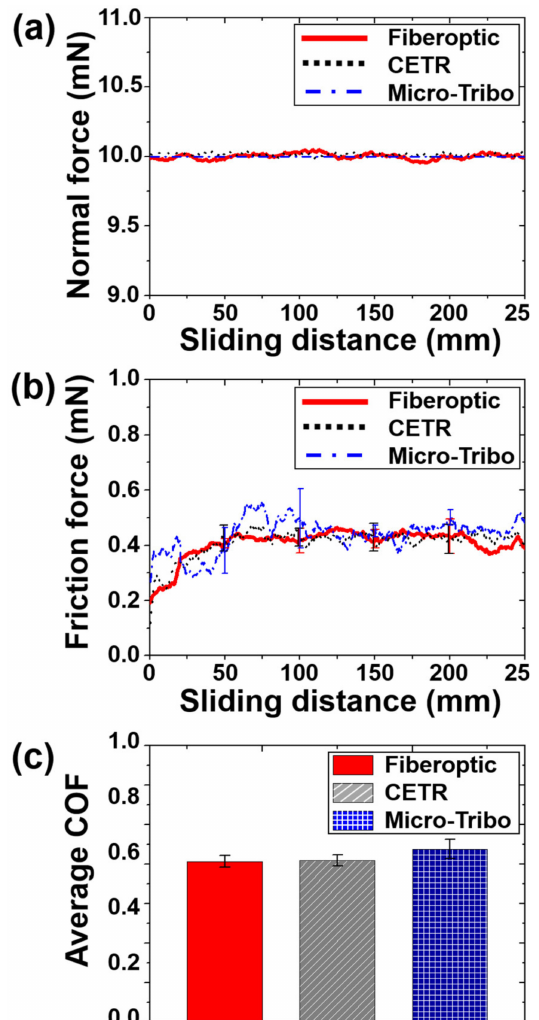
Figure 5. Variation of the ( a ) normal force and ( b ) friction coe ffi cient with respect to the sliding distance; ( c ) average friction coe ffi cient (COF) measured using the cantilever tip of the fiberoptic sensor-cantilever tip-based tribotester, commercial (CETR) tribotester, and custom-built